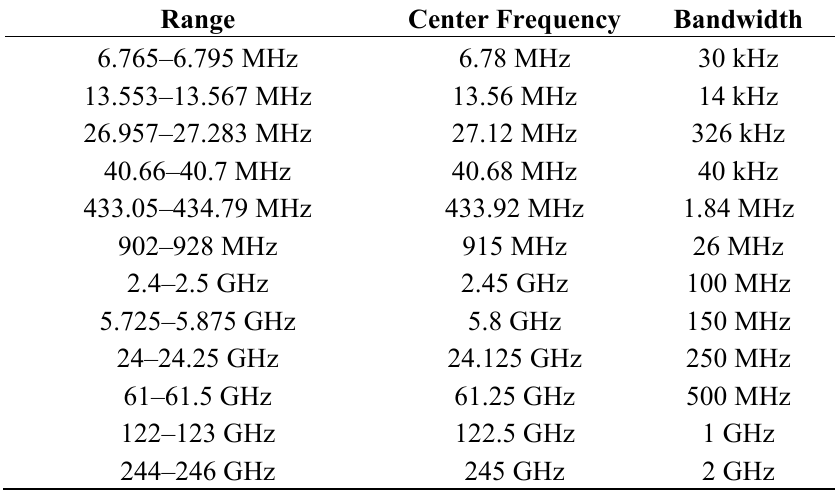
Table 2. Frequency bands available for ISM applications, as defined by